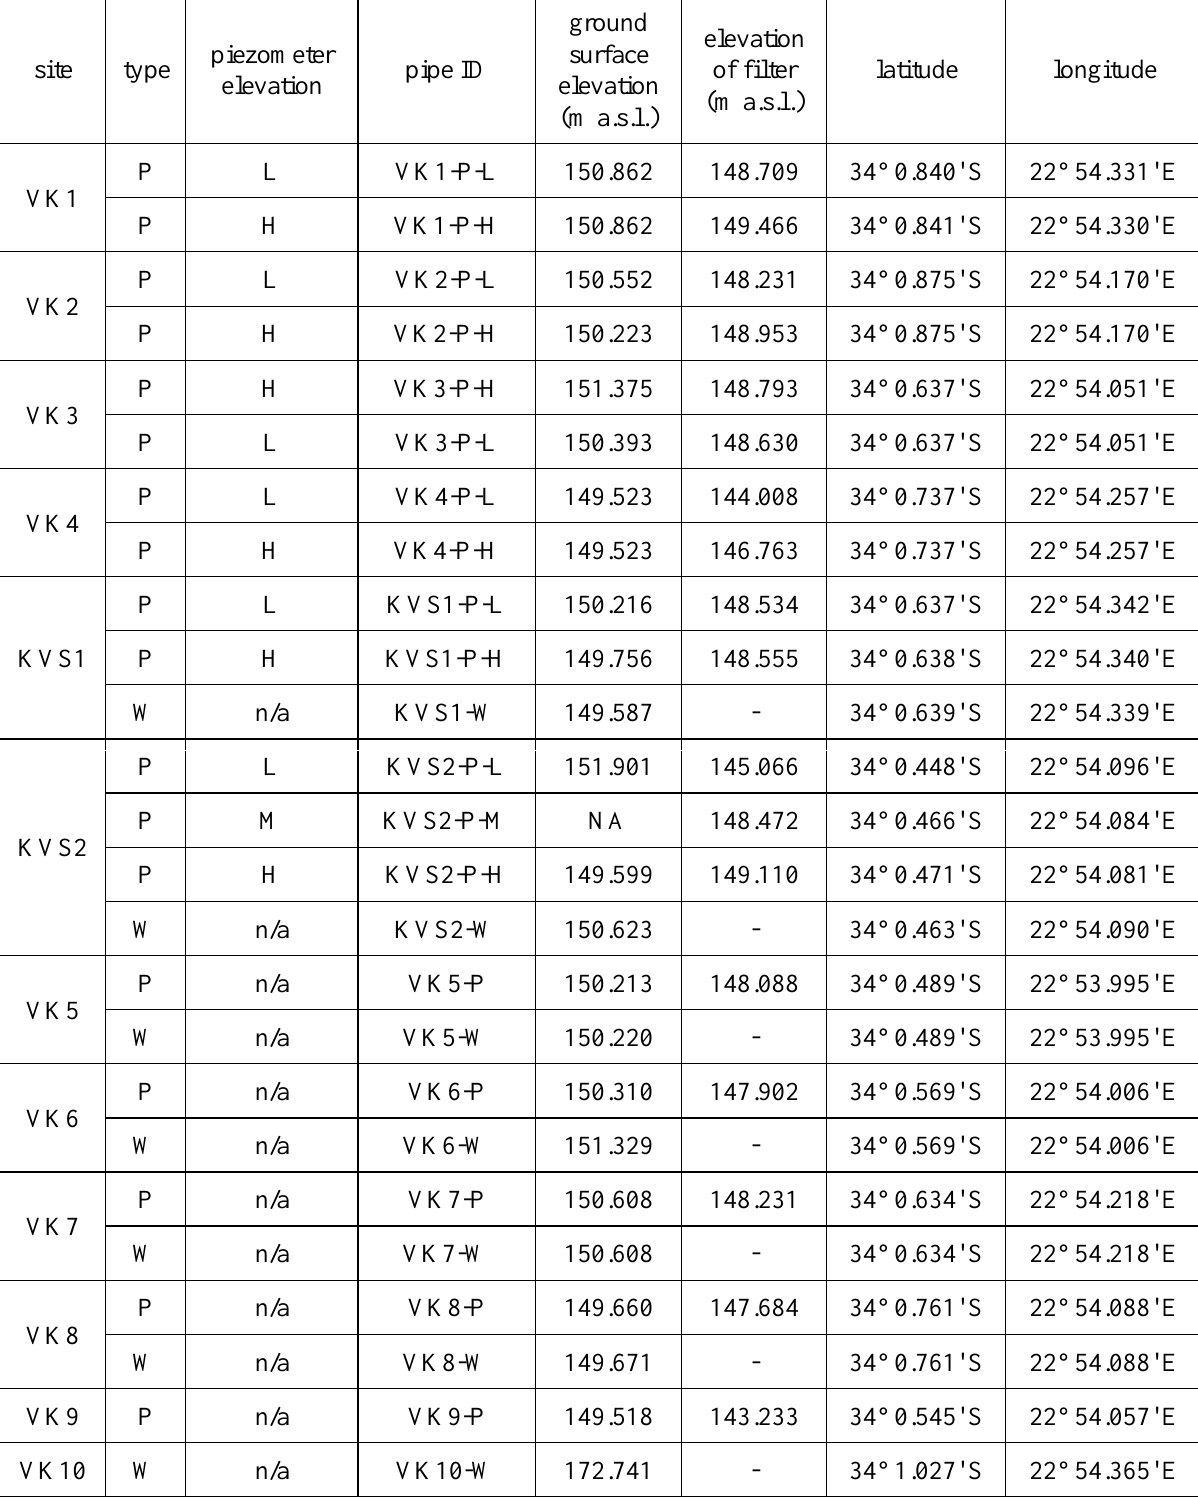
Table A1. Setup of the network of piezometers and wells in the research area. Types: P=piezometer, W=well. Piezometer elevations: H=high, M=medium,